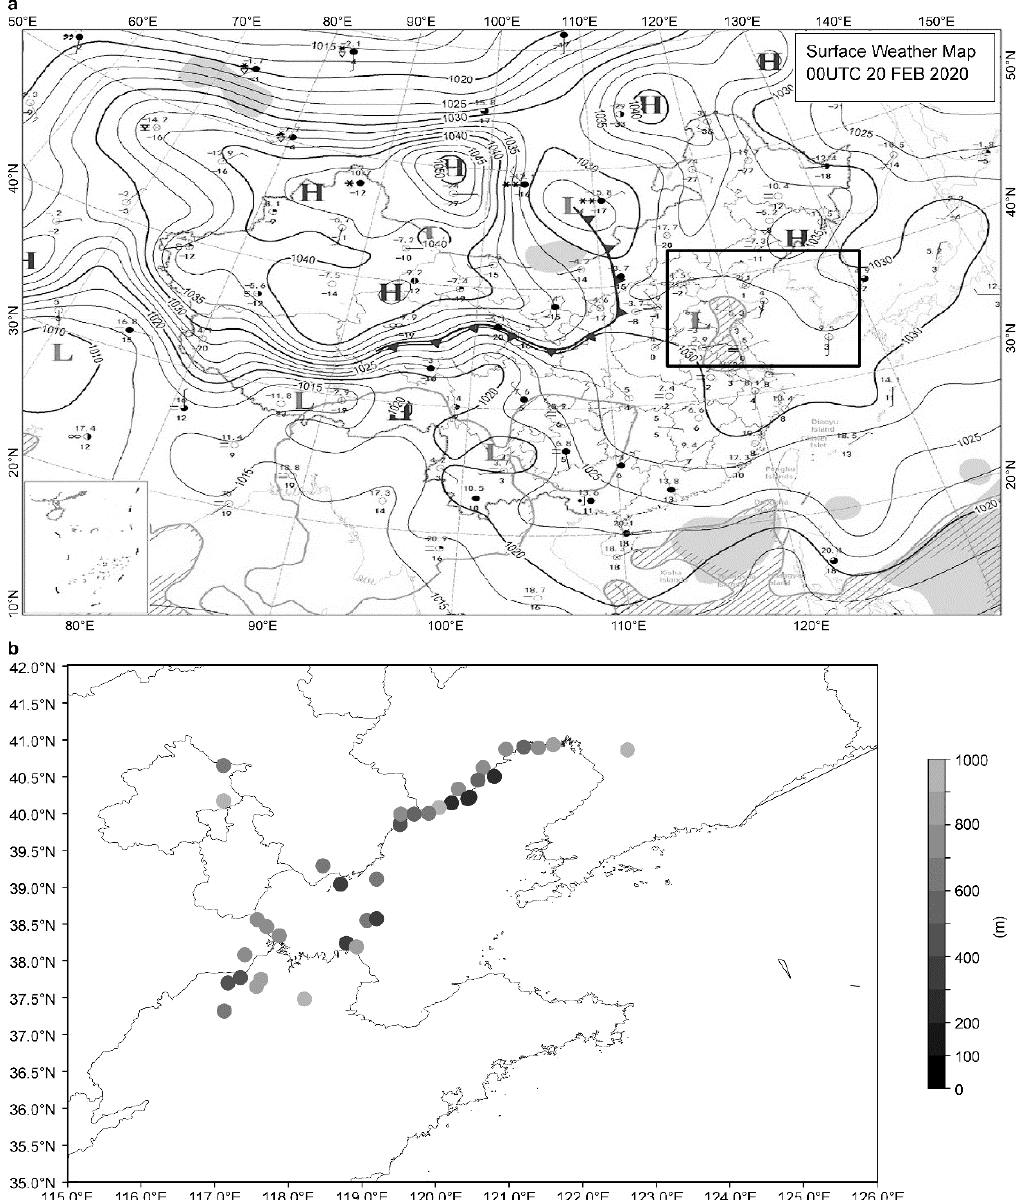
Figure 5. Weather map and position of the thick fog at 00:00 UTC on 20 February 2020. ( a ) Surface weather map, where the black frame on the surface map represents the study area; ( b ) Distribution of visibility less than 1000 m.